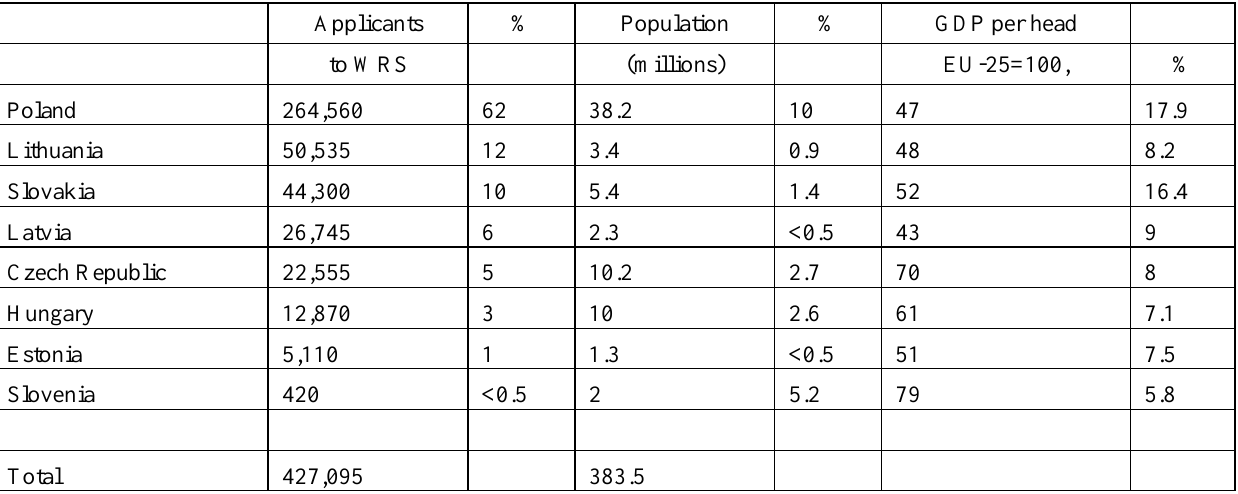
per head, 2004 and Unemployment rate,